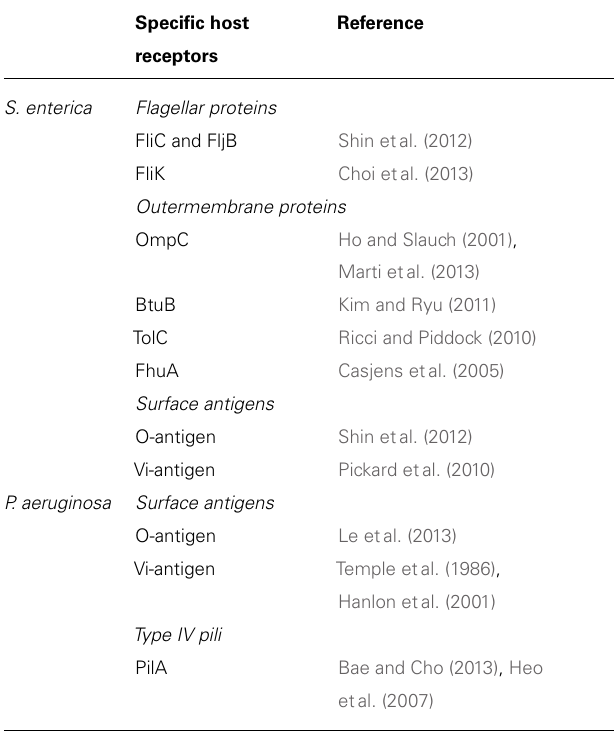
Table 1 | Specific host receptors for Salmonella and P. aeruginosa